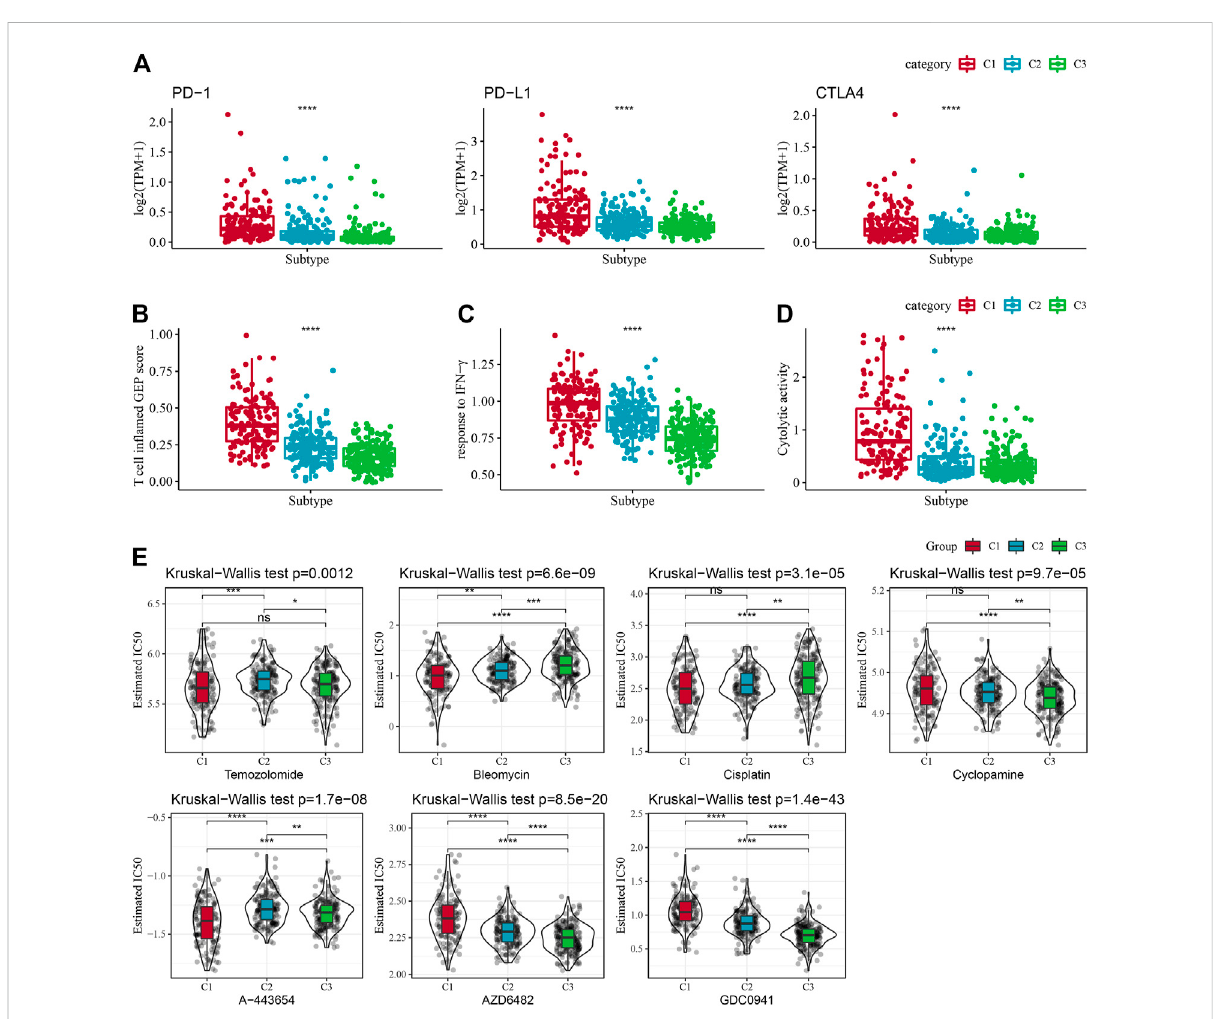
FIGURE 6 Immune characteristic scores re fl ecting the effect of immunotherapy for different subtypes. (A) Differences in T cell in fl amed GEP score in molecular subtypes. (B) Variations in response to IFN- γ in different molecular subtypes. (C) Differences in expression of immune checkpoint genes between molecular subtypes. (D) Variations in cytolytic activity between molecular subtypes. Cytolytic activity variations. (E) The box plots of the estimated IC50 for Temozolomide, Bleomycin, Cisplatin, Cyclopamine, A-443654, AZD6482, GDC0941, and Bleomycin in